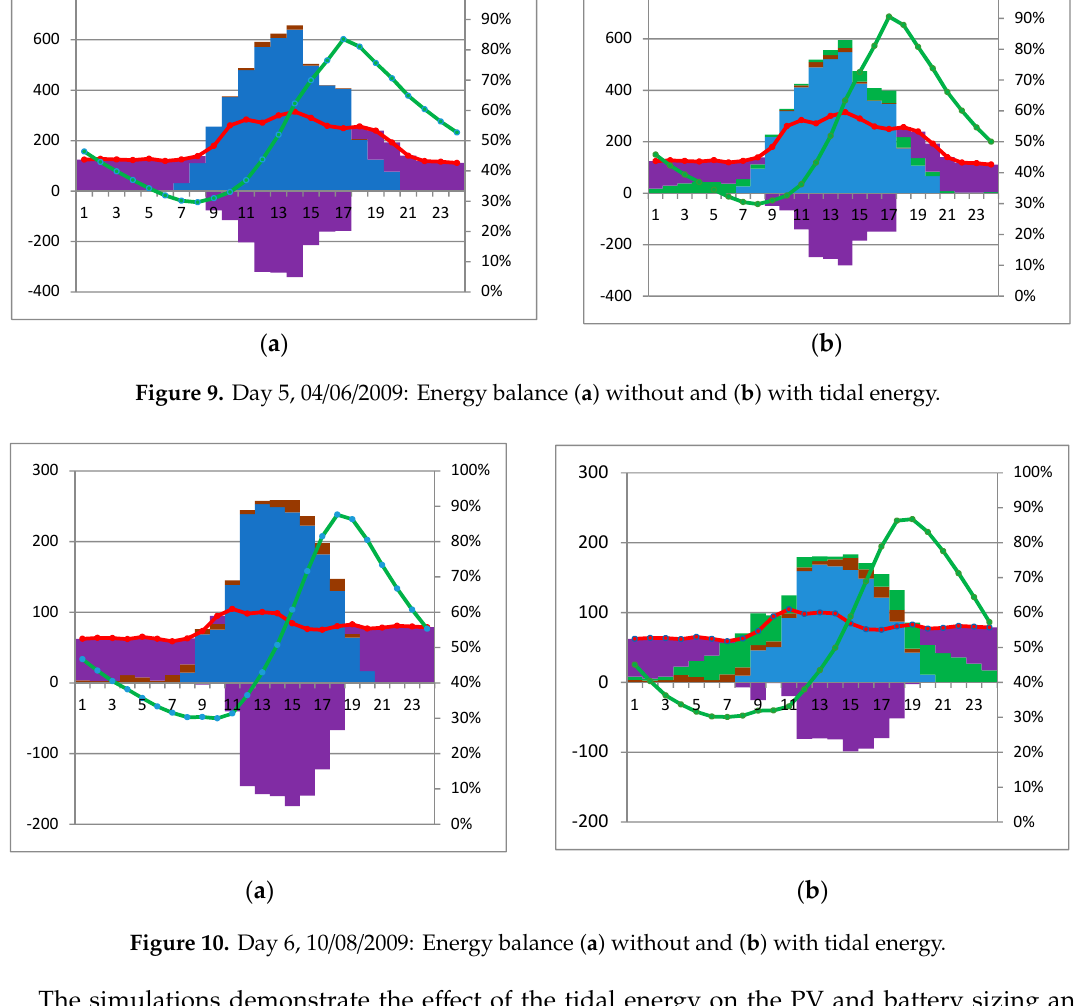
Figure 8. Day 4, 16/10/2009: Energy balance ( a ) without and ( b ) with tidal energy.